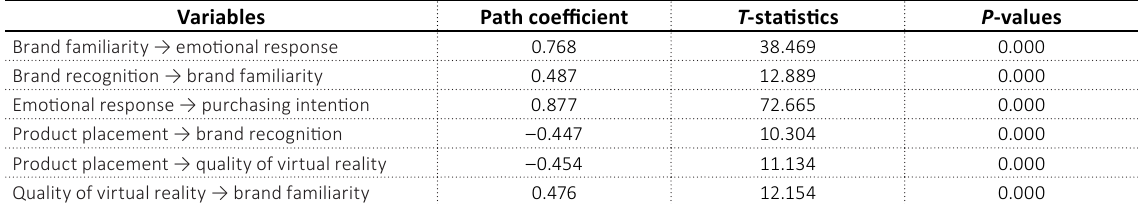
Table 3. Hypotheses